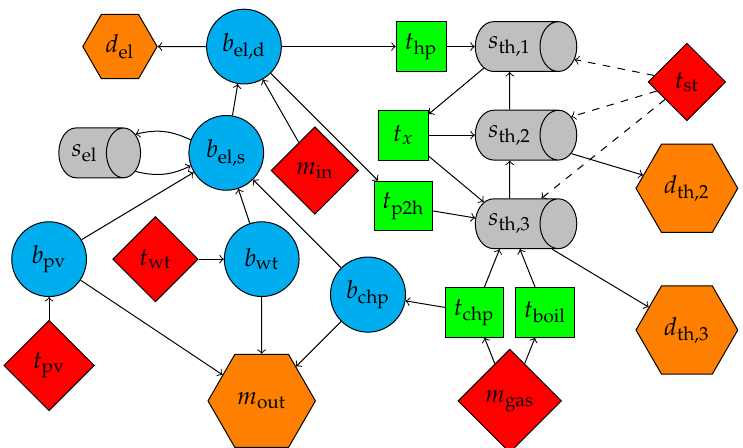
Figure 2. Depiction of the directed graph meta-model used as base-layout for the integrated energy system. Note that technologies may be optimized out (to have zero size). On display are, among